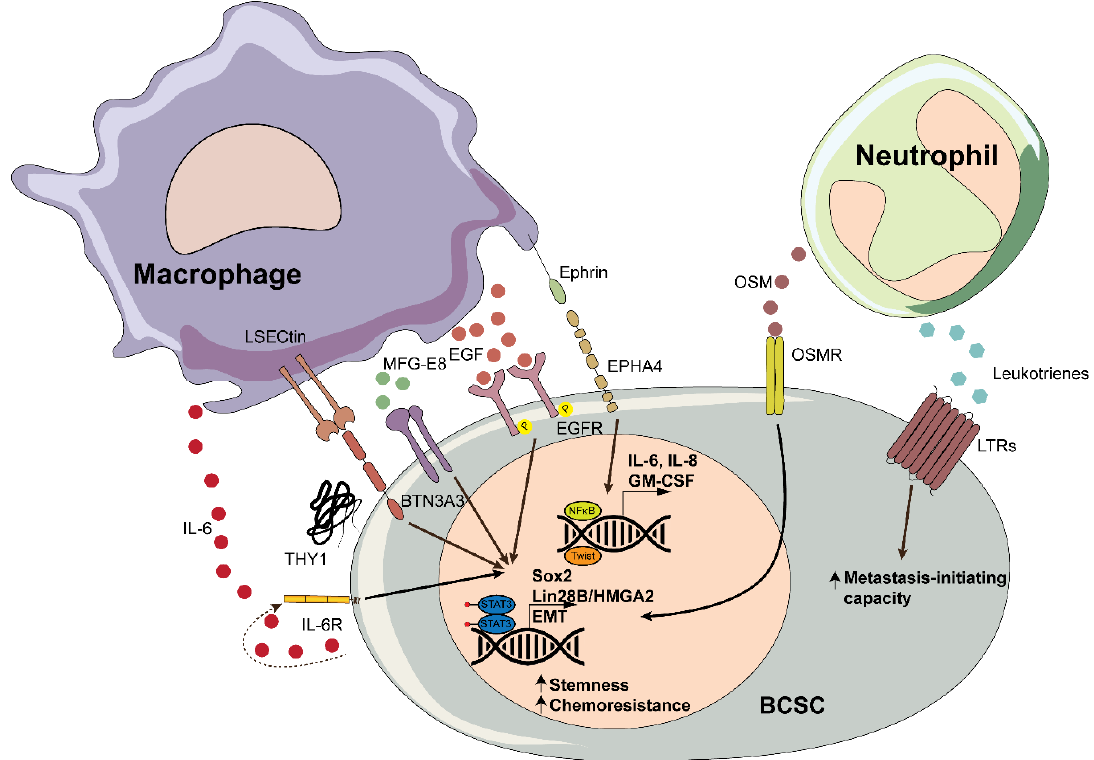
Figure 1. Schematic representation of interactions between myeloid cells and breast cancer stem cells (BCSCs).